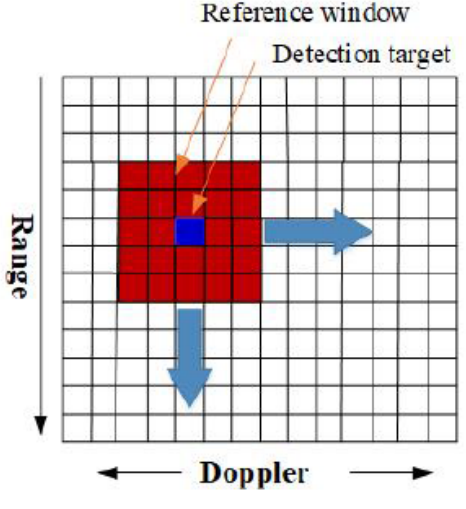
Figure 3. RDM detection